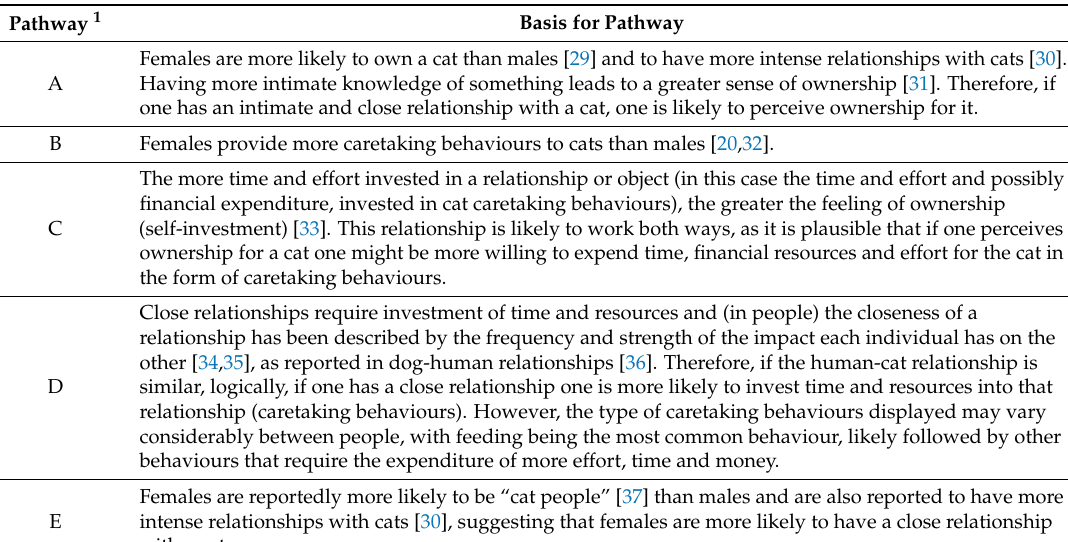
passively acquired cats at the time the cat was surrendered (Figure